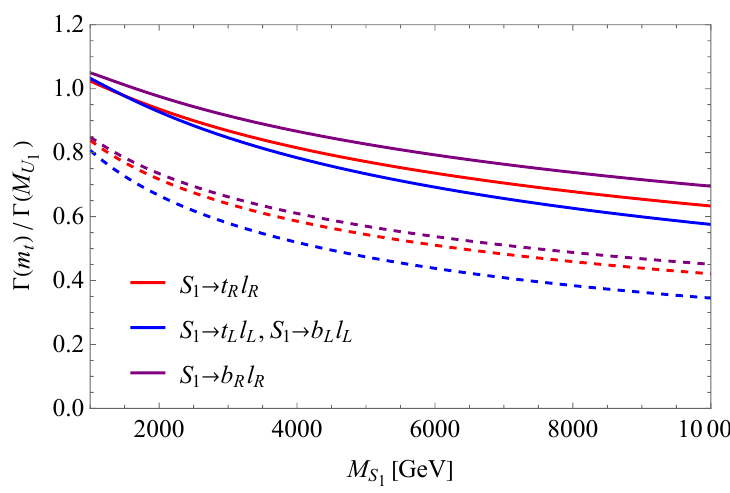
Figure 1 . Resummation effects on the tree-level decay rates for the two-jet decays S 1 → t R ‘ R (red), S 1 → t L ‘ L and S 1 → b L ‘ L (blue), and S 1 → b R ‘ R (purple) as a function of the leptoquark mass M S . The relevant Wilson coefficients are evolved from the scale of the leptoquark mass down 1 to µ = m t . The solid lines show the results of a complete numerical solution of the RG equations, while the dashed curves are obtained by retaining only the cusp terms in the anomalous